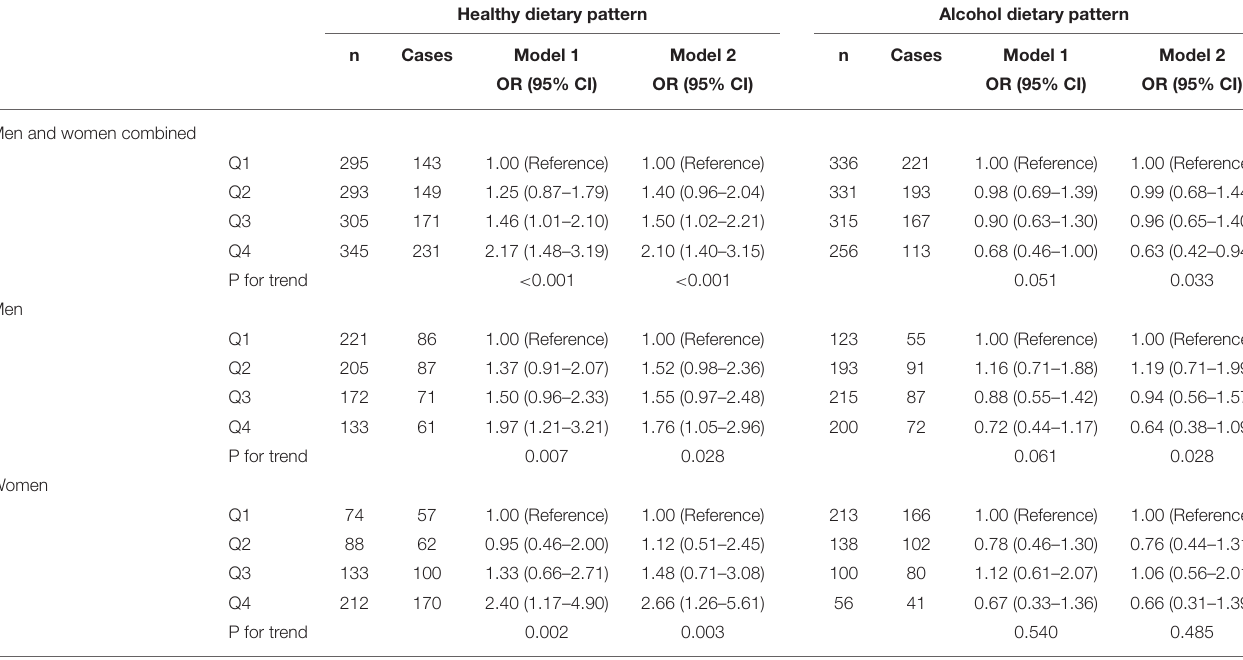
TABLE 4 | Odds ratios and 95% confidence intervals for the prevalence of the MHNO phenotype according to dietary pattern score quartile in the non-obese